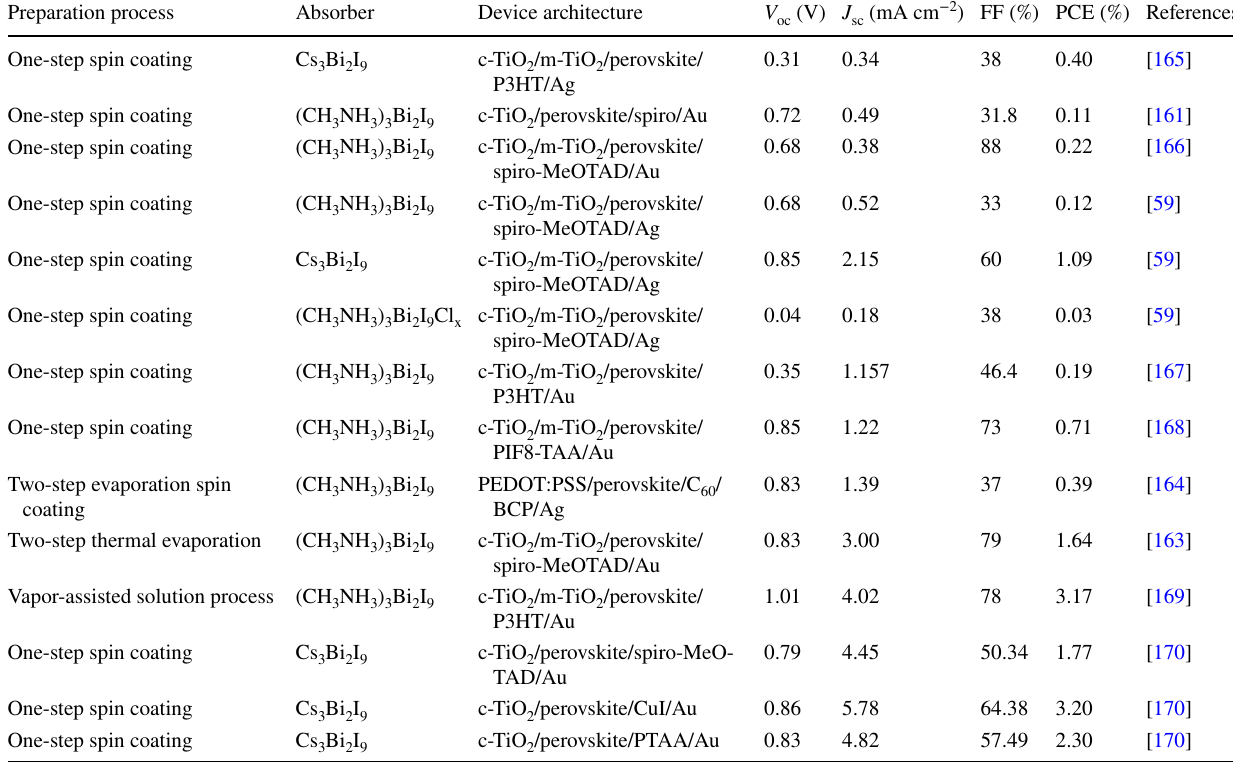
Table 2 Photovoltaic parameters of PSCs based on various Bi-based perovskite absorbers Preparation